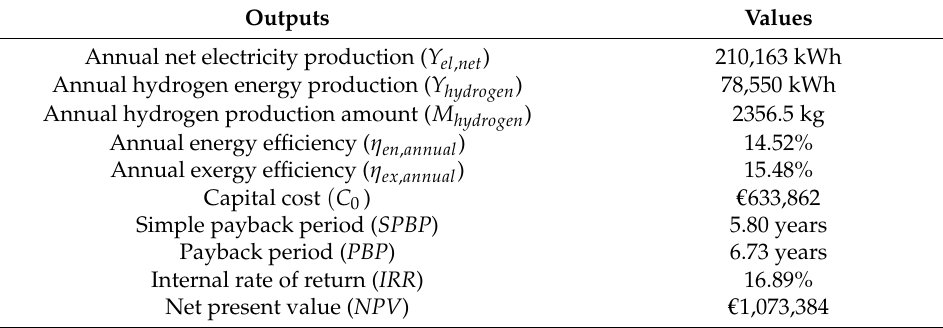
Figure 16. Objective function ( F ) values for different values of net electricity load and TES tank volume when the hydrogen price is equal to 25 EUR/kg. Table 7. Outputs of the optimum